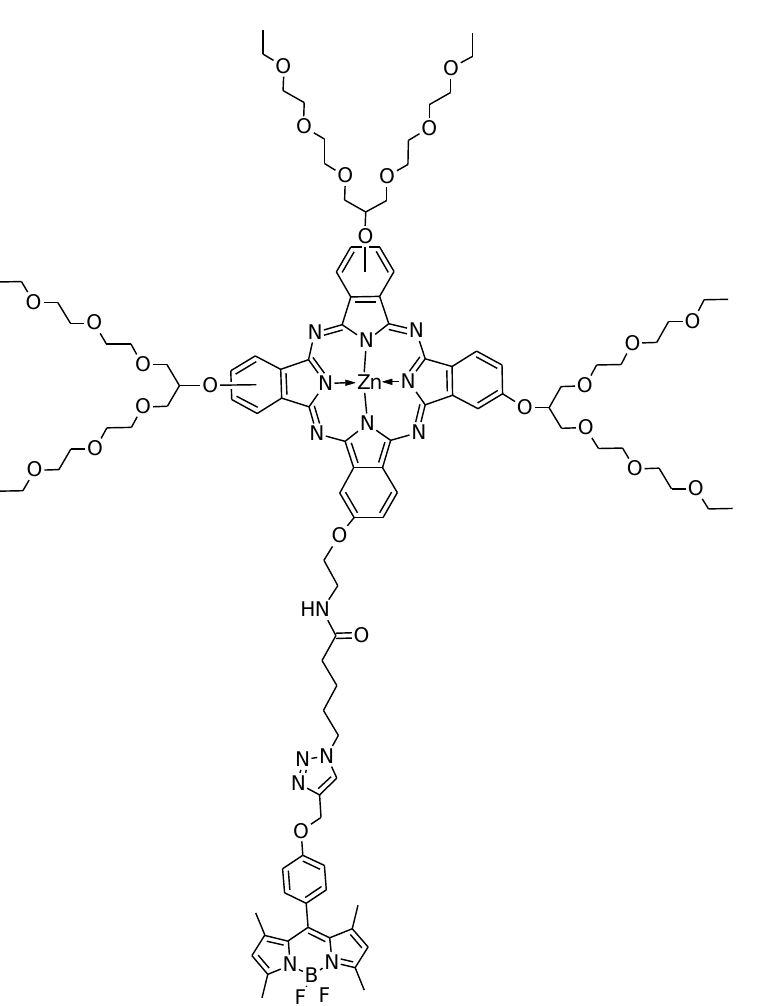
Figure 9. The chemical structure of the conjugate of substituted zinc(II) phthalocyanine and BODIPY dye [132].